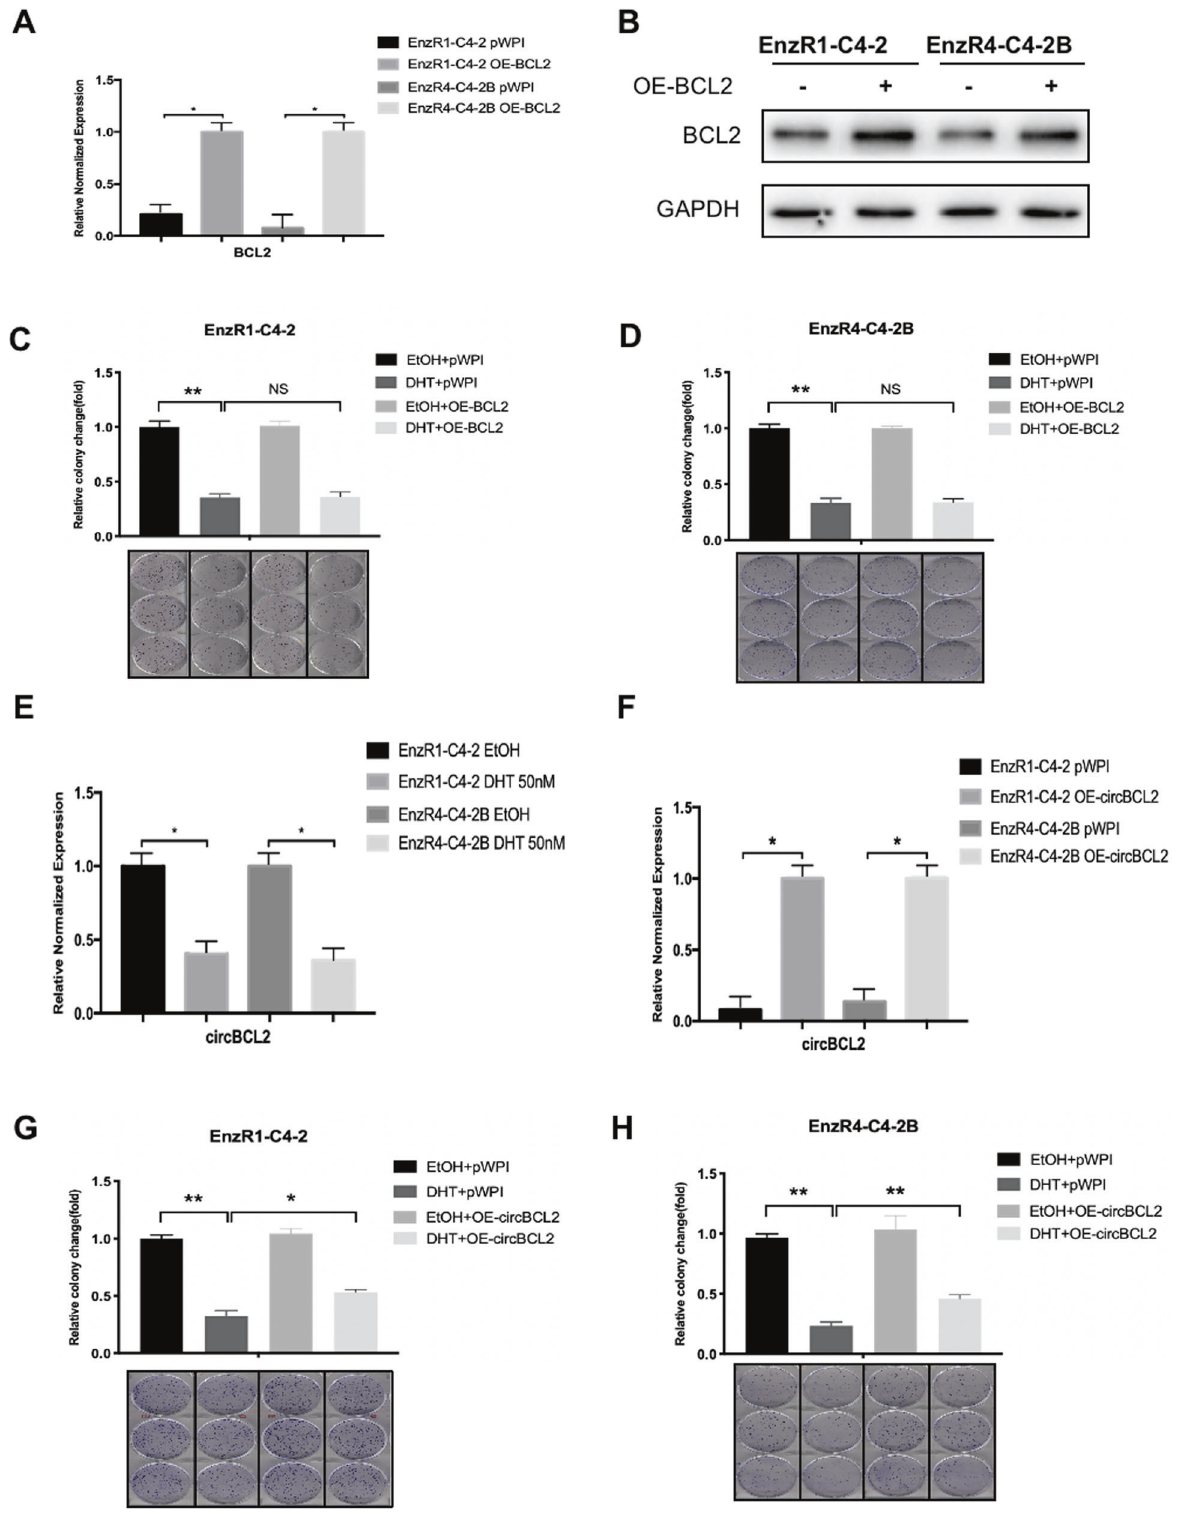
Fig. 3 Increasing BCL2 could not block, while increasing circBCL2 could reverse, the DHT inhibition effect on the EnzR PCa cell growth. A The qRT-PCR was performed to show quanti fi cation of BCL2 overexpressing (OE) BCL2 (OE-BCL2) in EnzR1-C4-2 and EnzR4-C4-2B cell lines with/without (w/wo) OE-BCL2. B Western blot assays show BCL2 expression in EnzR1-C4-2 and EnzR4-C4-2B cell lines w/wo OE-BCL2. C , D Colony formation assays show cell growth with 50 nM DHT in EnzR1-C4-2 ( C ) and EnzR4-C4-2B ( D ) cells. E The circBCL2 expression in EnzR1-C4-2 and EnzR4-C4-2B cell lines with 50 nM DHT. F The qRT-PCR was performed to show quanti fi cation of circBCL2 w/wo OE-circBCL2 treated w/wo 50 nM DHT. G , H Colony formation assays show cell growth with 50 nM DHT in EnzR1-C4-2 and EnzR4-C4-2B cell lines w/wo OE-circBCL2. Data are presented as means ± SD. * p < 0.05, ** p < 0.01, NS not signi fi cant.